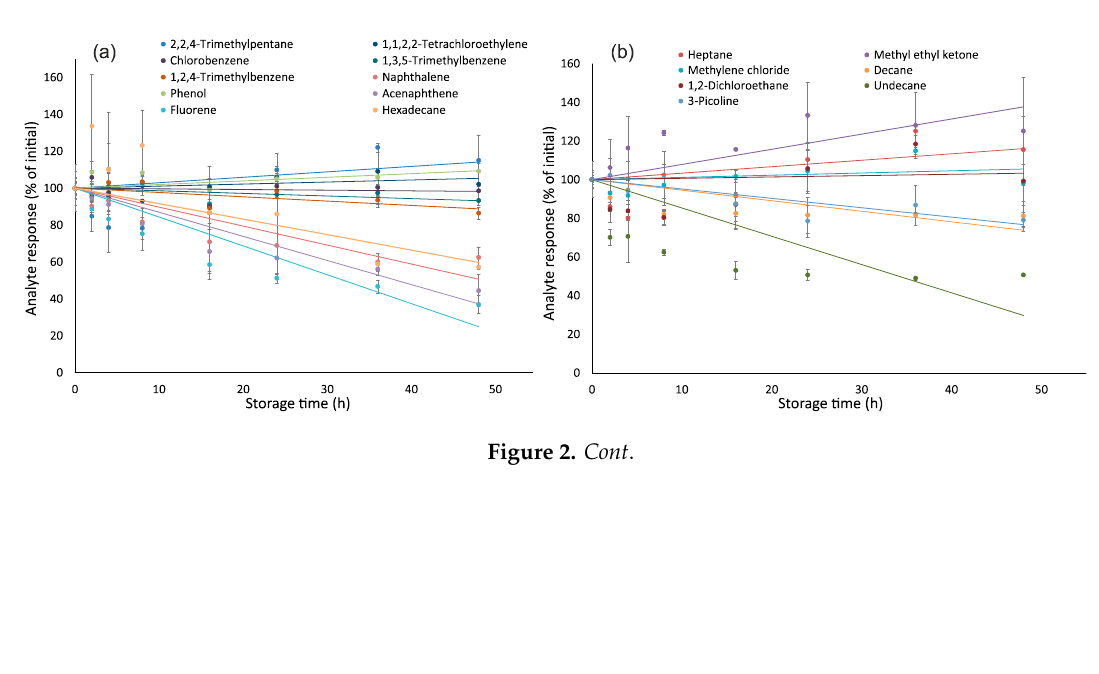
Figure 2. Effect of storage time on responses of analytes: ( a )—2,2,4-trimethylpentane, chlorobenzene, 1,2,4-trimethylbenzene, phenol, fluorene,